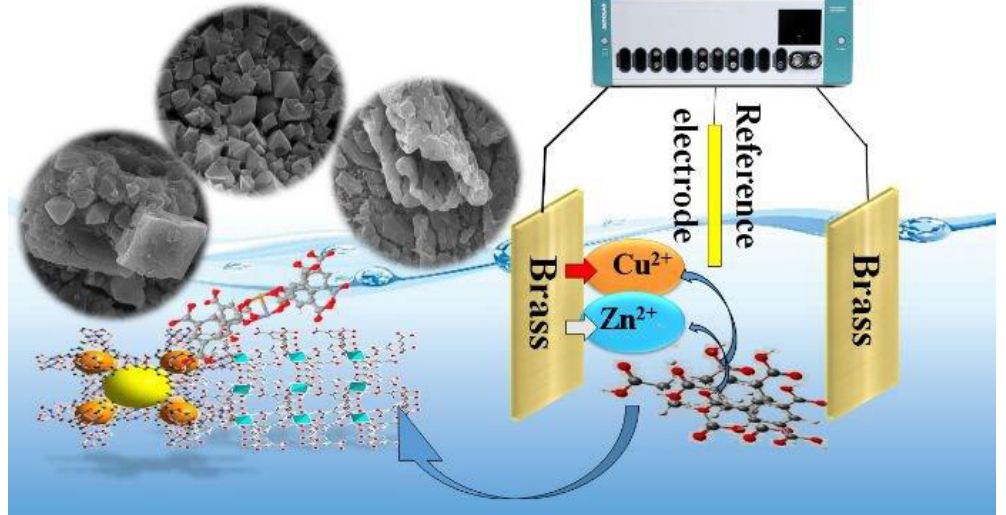
Figure 4. Simultaneous electrosynthesis of MOFs on brass by the electrochemical technique; by in- creasing the potential from 1 to 10 volts, different morphologies and smaller crystals are created [110].